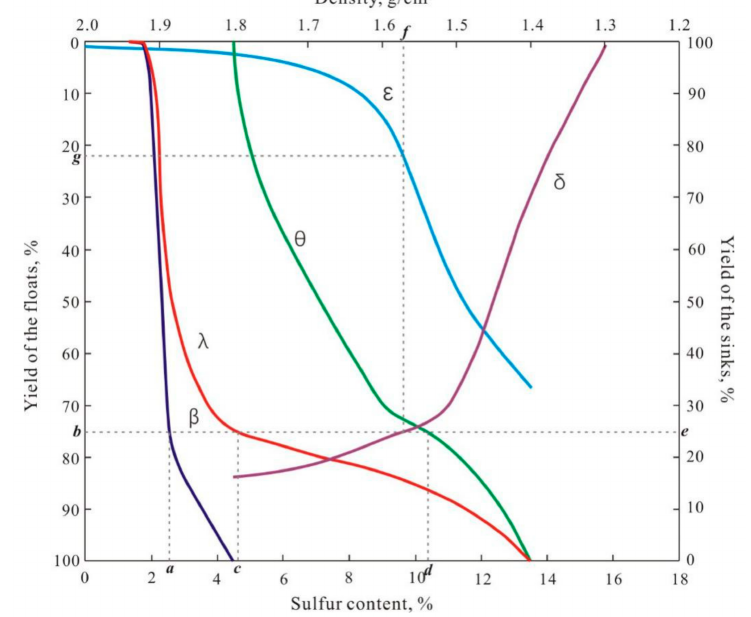
Figure 5. Sulfur based washability curve (H–R) for the Run-of-Mine (ROM) coal. λ —sulfur content curve, β —floats curve, θ —sinks curve, δ —density curve, ε — δ ± 0.1 curve.